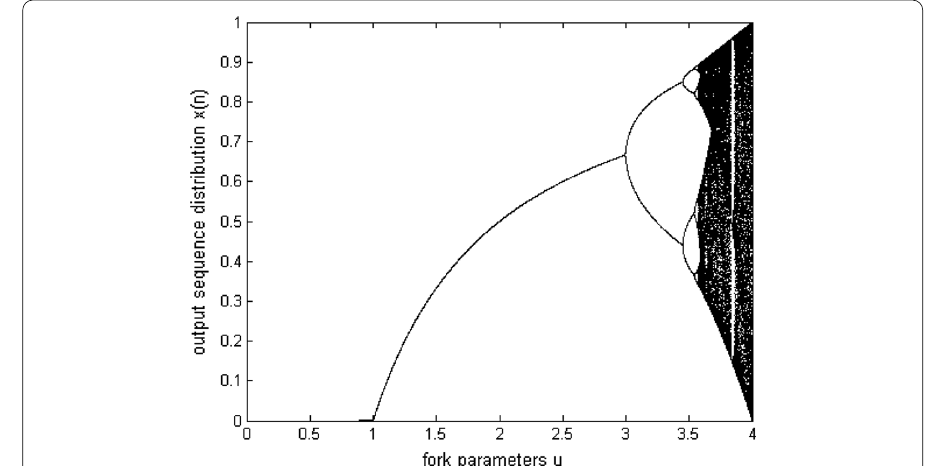
Fig. 1 Traditional Logistic mapping bifurcation diagram